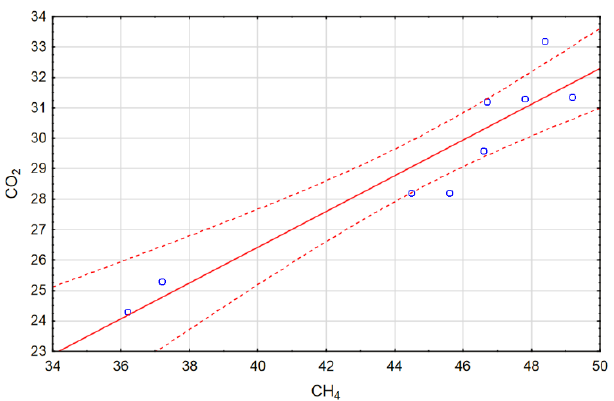
Figure 4. Scatterplot of the correlation between CO 2 and CH 4 .